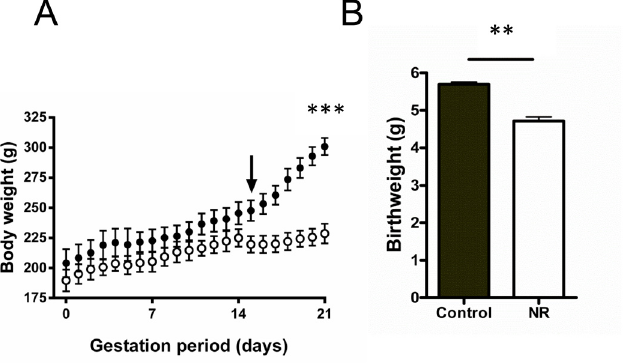
Fig 2. Maternal weight gain during pregnancy and subsequent birth weight of pups. (A) Maternal weight gain is shown for both Control ( ● , n = 5) and nutrient restricted ( (cid:3) , n = 5) groups over the course of gestation. Nutrient restriction was induced at day 14 (downward arrow) until parturition at day 21. All data are mean ± SEM. (Student ’ s t-test, *** P < 0.001). (B) Mean birth weight (+SEM) for Control (n = 51) and nutrient restricted (n = 52) pups. Nutrient restricted pups were found to be significantly smaller than controls (ANCOVA, C: 5.61 g ± 0.05 Vs. NR: 4.59 g ± 0.07; F (1, 8) = 15.724, ** P < 0.01). Nested model analysis suggested a large grouping effect associated with the intrauterine environment from which litters of pups were derived (ANCOVA, F (8, 93) = 17.193, ** P < 0.01). Birth weight distribution of control pups indicated a lower 10 th percentile of 5.1 g, with > 80% of NR pups falling below this